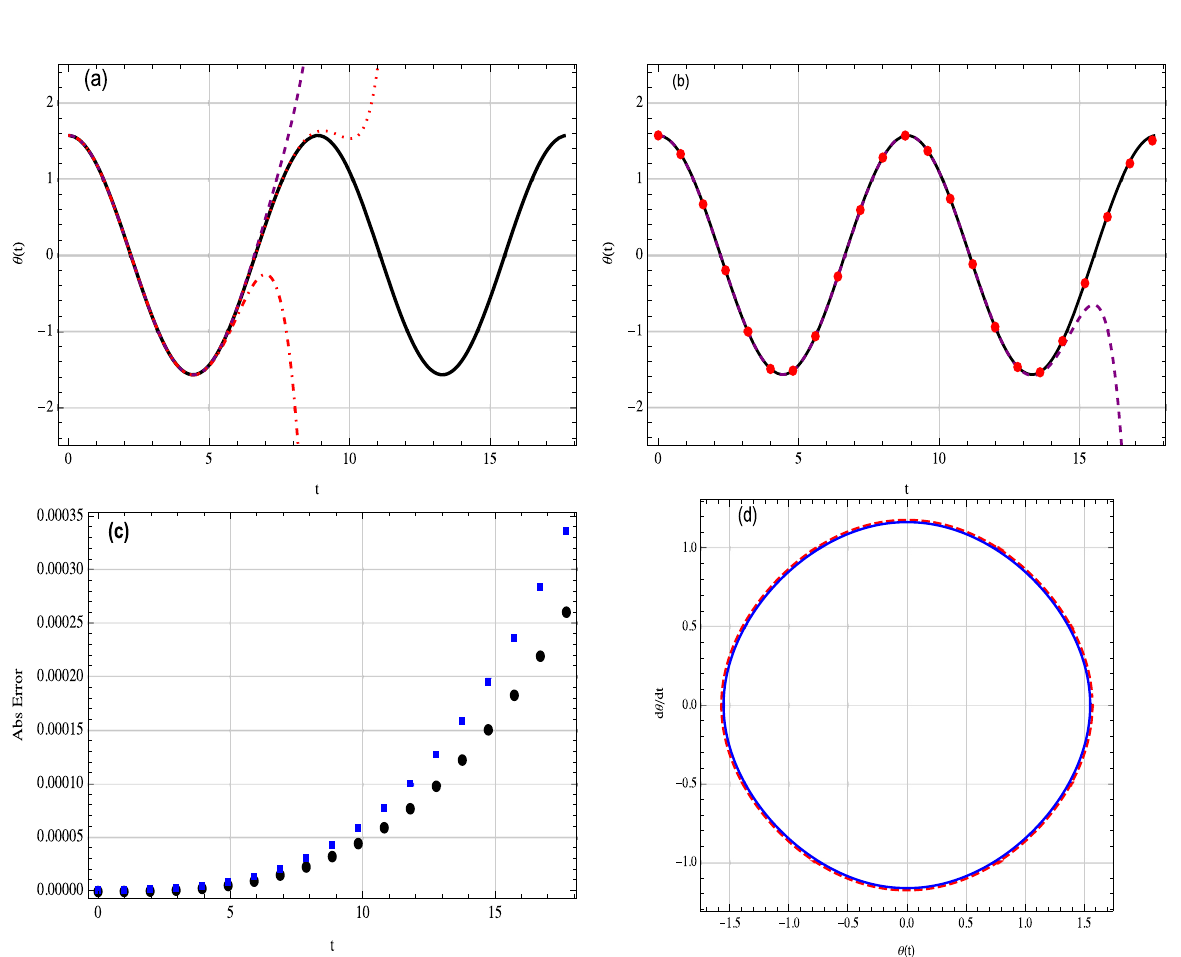
Figure 3: ( a ) Comparison of the MDM approximation θ t π , 0, 2, 0 10 ( ) / ( dash - dotted line ) , θ t π , 0, 2, 0 14 ( ) / ( dashed line ) , θ t π , 0, 2, 0 16 ( ) / ( dotted line ) , and the exact solution ( solid line ) . ( b ) The exact solution ( solid line ) , the 20th - order MDM numeric solution θ h 0.3 = ( dashed line ) and the 25th - order MDM numeric solution θ with the exact solution ( dots ) and the 25th - order ADM numeric solution ( squares ) , respectively. ( d ) Phase plane diagram, exact ( solid line ) 25 ⟨ ⟩ approximation ( dashed line ) for Example and θ k